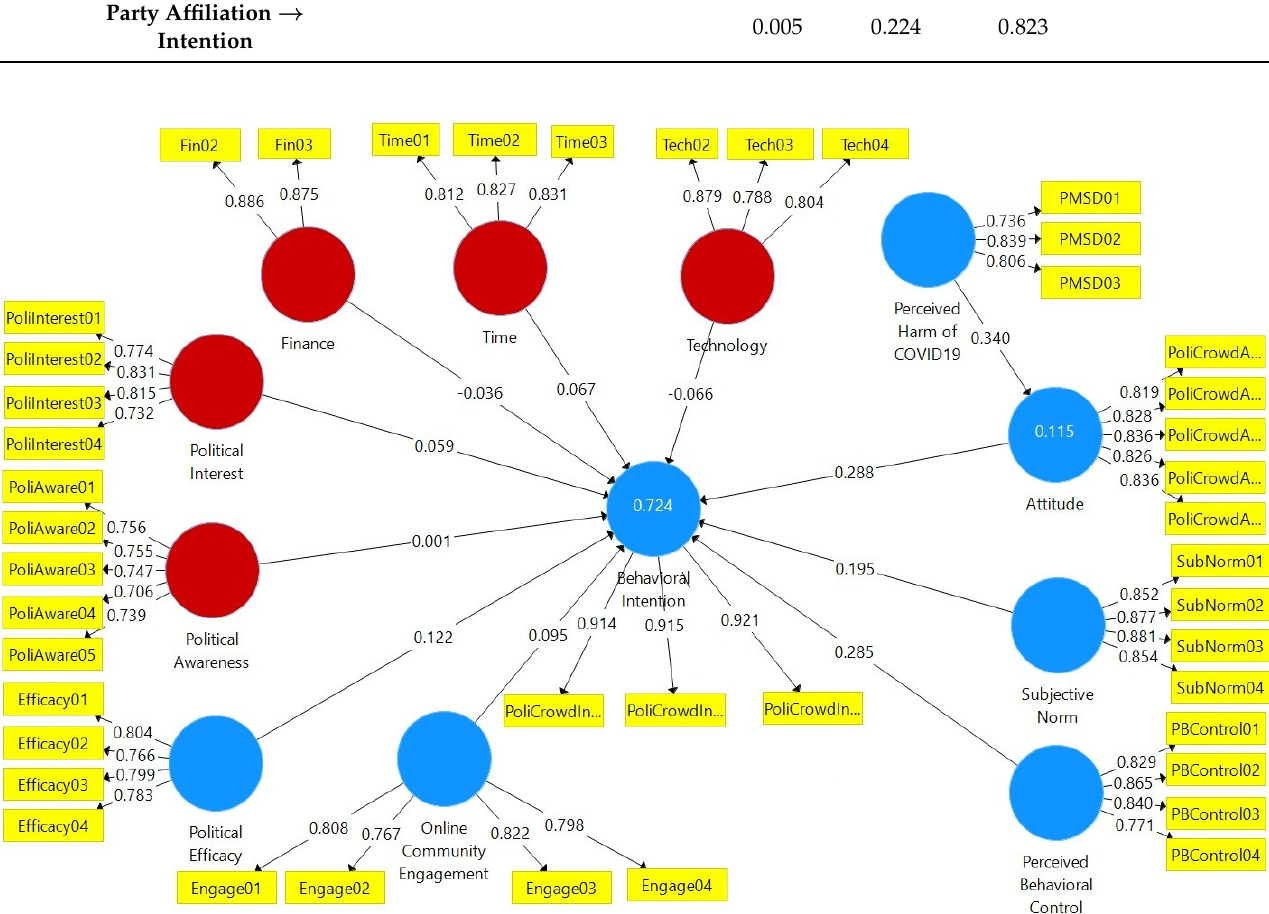
Figure 2. PLS-SEM Estimated model. Blue-colored factors are significant at p < 0.01 & p < 0.5. Red-colored factors are insignificant.